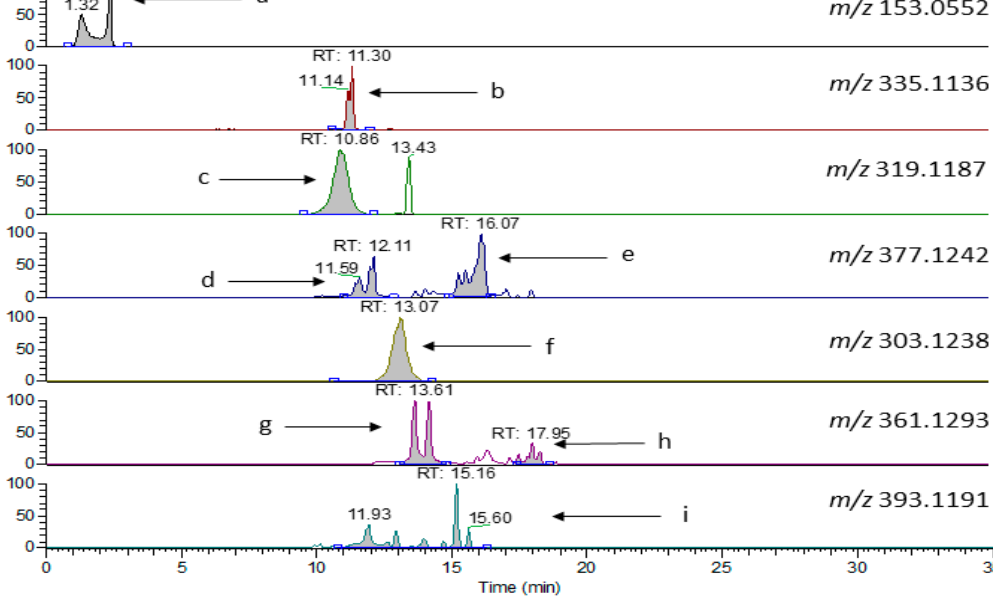
Table 5. Total (free and bound forms) Htyr and Tyr content (mg/20 g oil) of VOO samples according to protocol E.